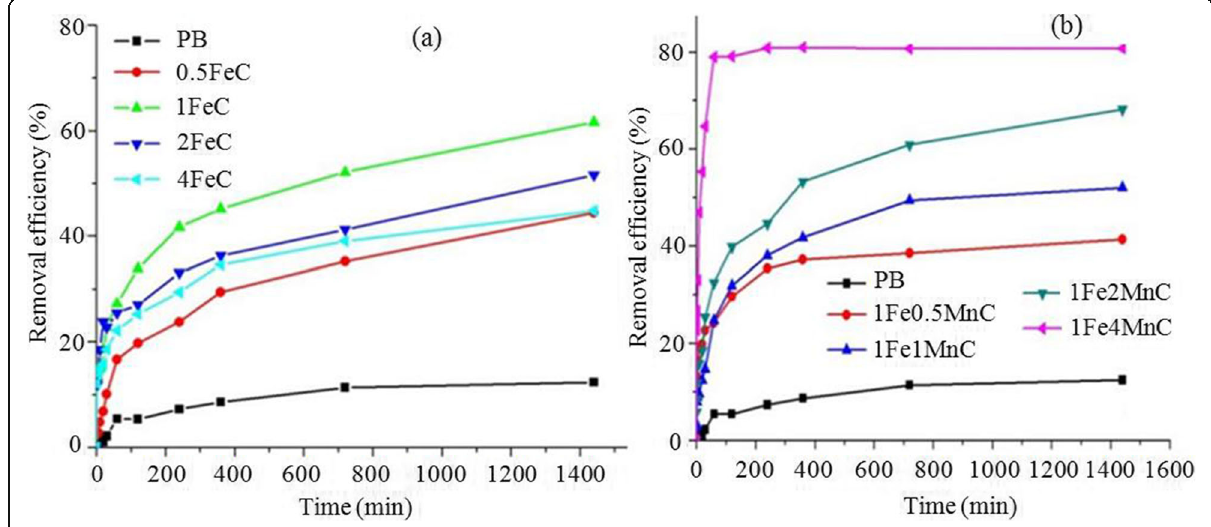
Fig. 6 As removal efficiency with a x FeC and b x Fe y